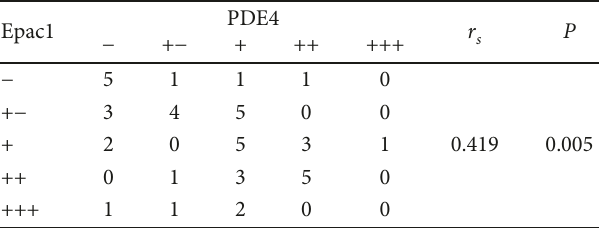
Figure 1: Epac1 and PDE4 expression in rectal carcinoma tissues ( × 400). The sub fi gures (a), (b), (c), and (d) indicated the protein expression of Epac1 in rectal cancer tissues. (a) No expression. (b) Moderately expression. (c, d) High expression levels, expression in the cytoplasm and in the nucleus. The sub fi gures (e), (f), (g), (h), and (i) indicated the protein expression of PDE4 in rectal cancer tissues. (e) No expression. (f) The top of the picture is moderately expression, and the bottom is no expression. (g) Low expression levels. (h) Moderately expression. (i) High expression levels, mainly in the cytoplasm, with low amounts in the nucleus. Table 2: Correlation between PDE4 and Epac1 protein levels in Table 3: Correlation between PDE4 and cyclin E1 protein levels in rectal cancer. rectal